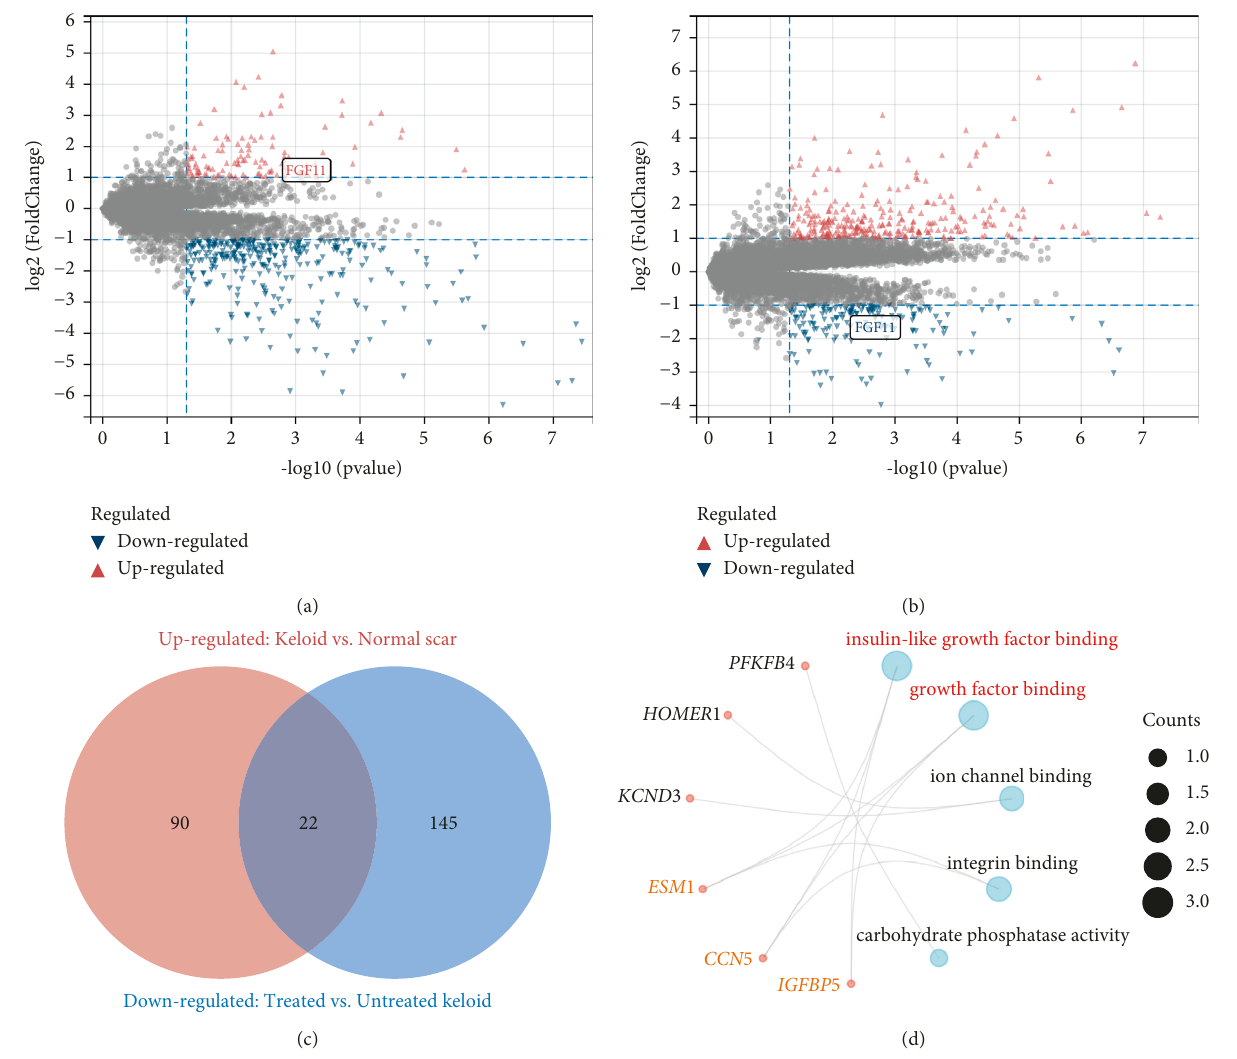
Figure 1: The intersection of differentially upregulated genes in keloids but downregulated after hydrocortisone treatment. (a) Differential analysis between keloid samples without hydrocortisone treatment versus normal scar tissue without treatment. (b) Differential analysis between treated and untreated keloid samples. (c) Venn plot of genes not only upregulated in keloid tissue but also downregulated after exposure to hydrocortisone treatment. (d) Major molecular functions of common DEGs enriched based on gene ontology. Table 1: Functional enrichment analysis (gene ontology) revealed major molecular functions of common DEGs. Ontology